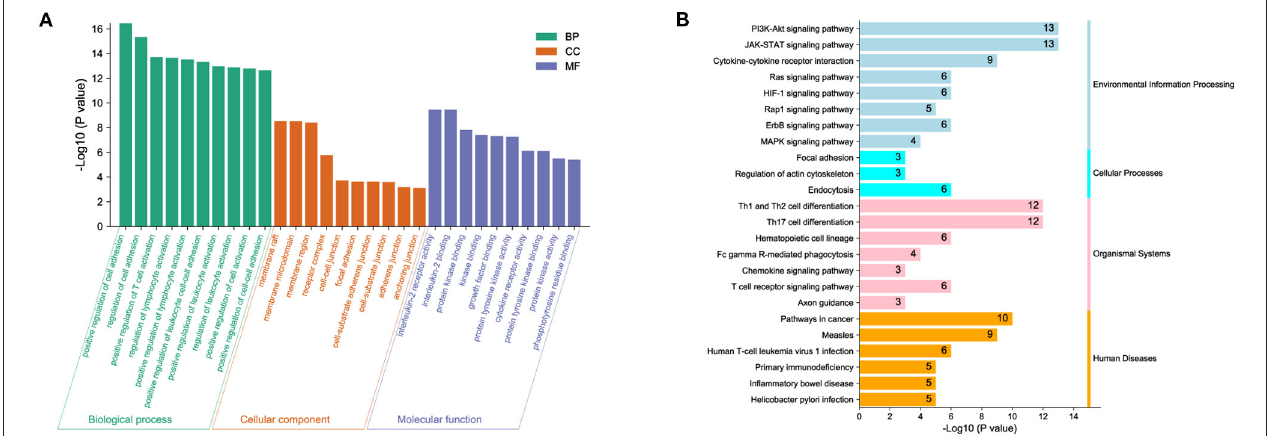
FIGURE 5 | Biological function analysis of DOK2. (A) Gene ontology and (B) pathway enrichment analysis for DOK2 and its interactive genes. Gene ontology (GO) included biological process (BP), molecular function (MF), and cellular component (CC); KEGG pathways included environmental information processing, cellular processes, organismal systems, and human